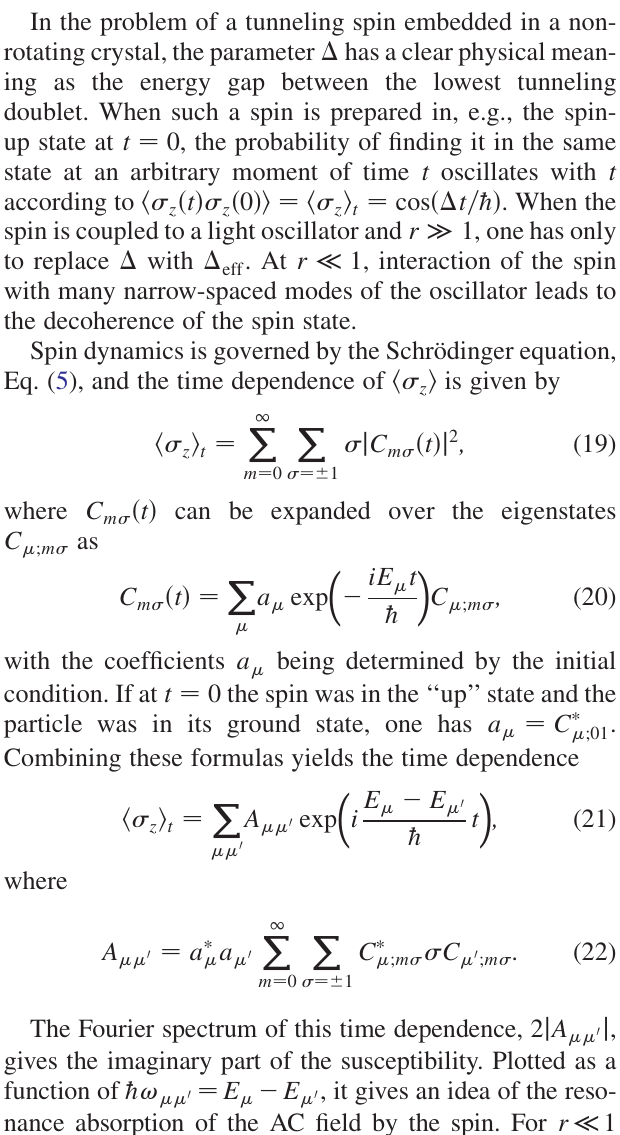
i for r ¼ 0 : 03 and (cid:3) ¼ 0 , 0.3, z t